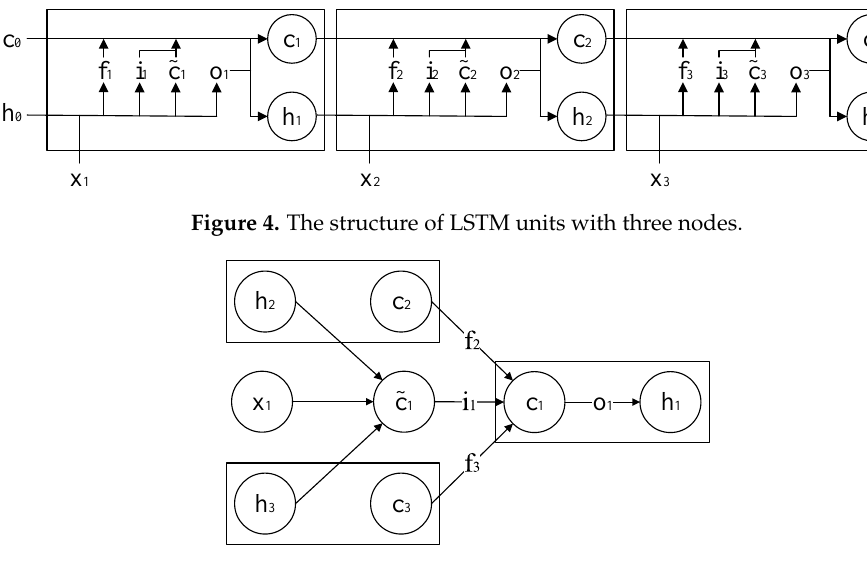
Figure 5. The structure of Tree-LSTM units with two child